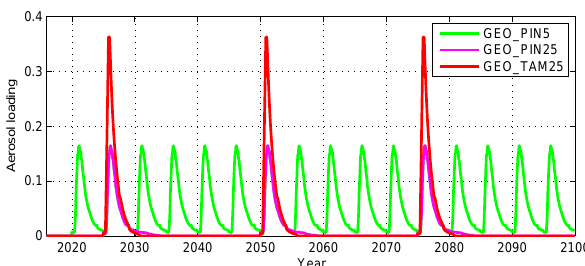
Fig. 1. Mean global change in aerosol loading (optical depth at 0.55µm) applied to simulate the volcanic forcings in the GEO TAM25, GEO PIN25, and GEO PIN5 experiments.